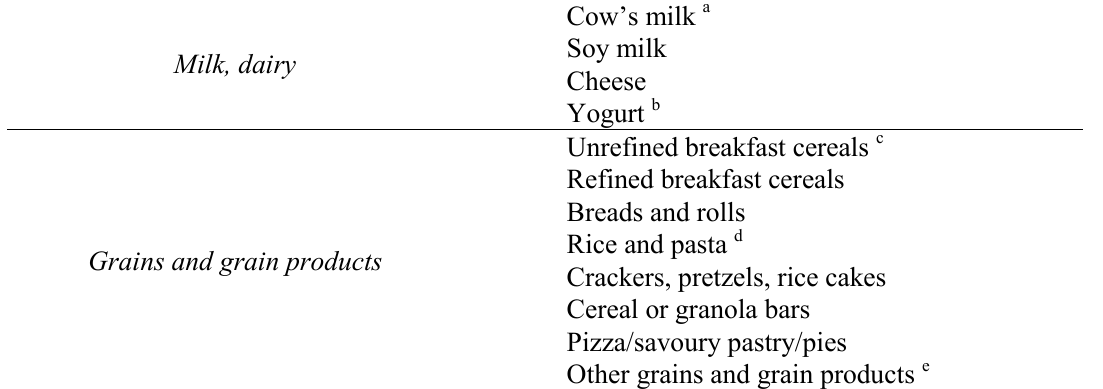
Table 1. Food groups used to calculate food variety